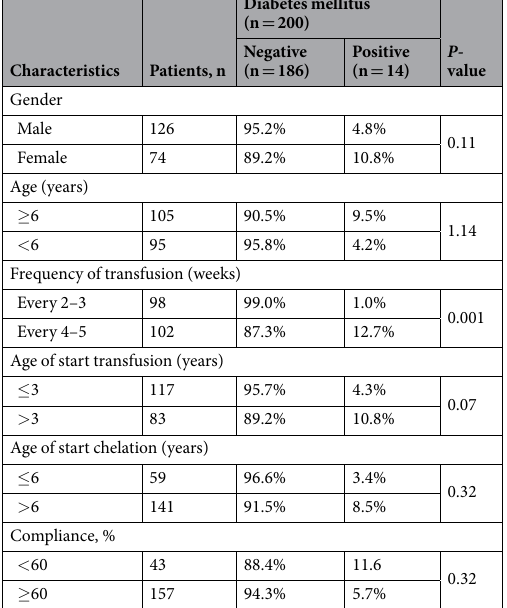
Table 5. Association between diabetes mellitus and each of the demographic, frequency of transfusion, age of start transfusion, Age of start chelation, compliance.